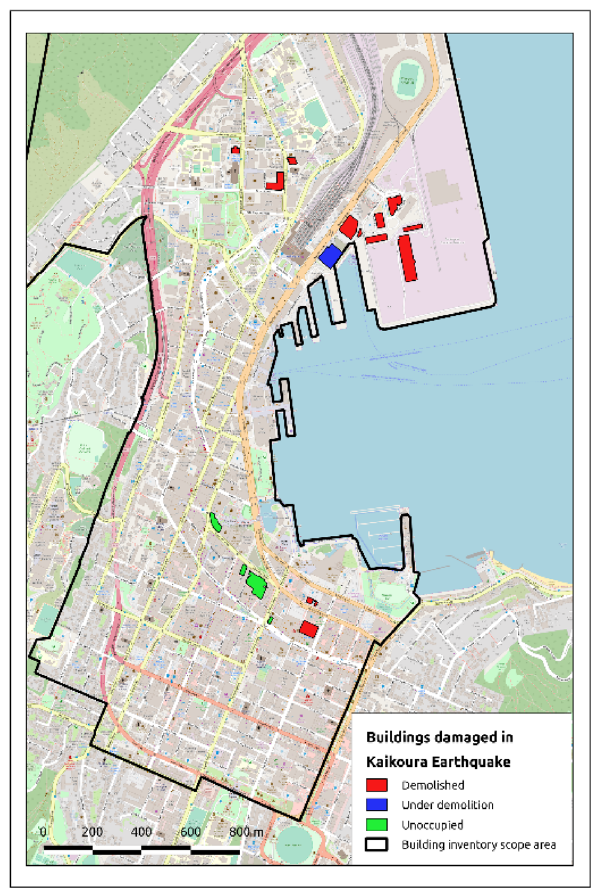
Fig. 2 Locations of damaged buildings in Wellington (as of February 2019) Source : Wellington City